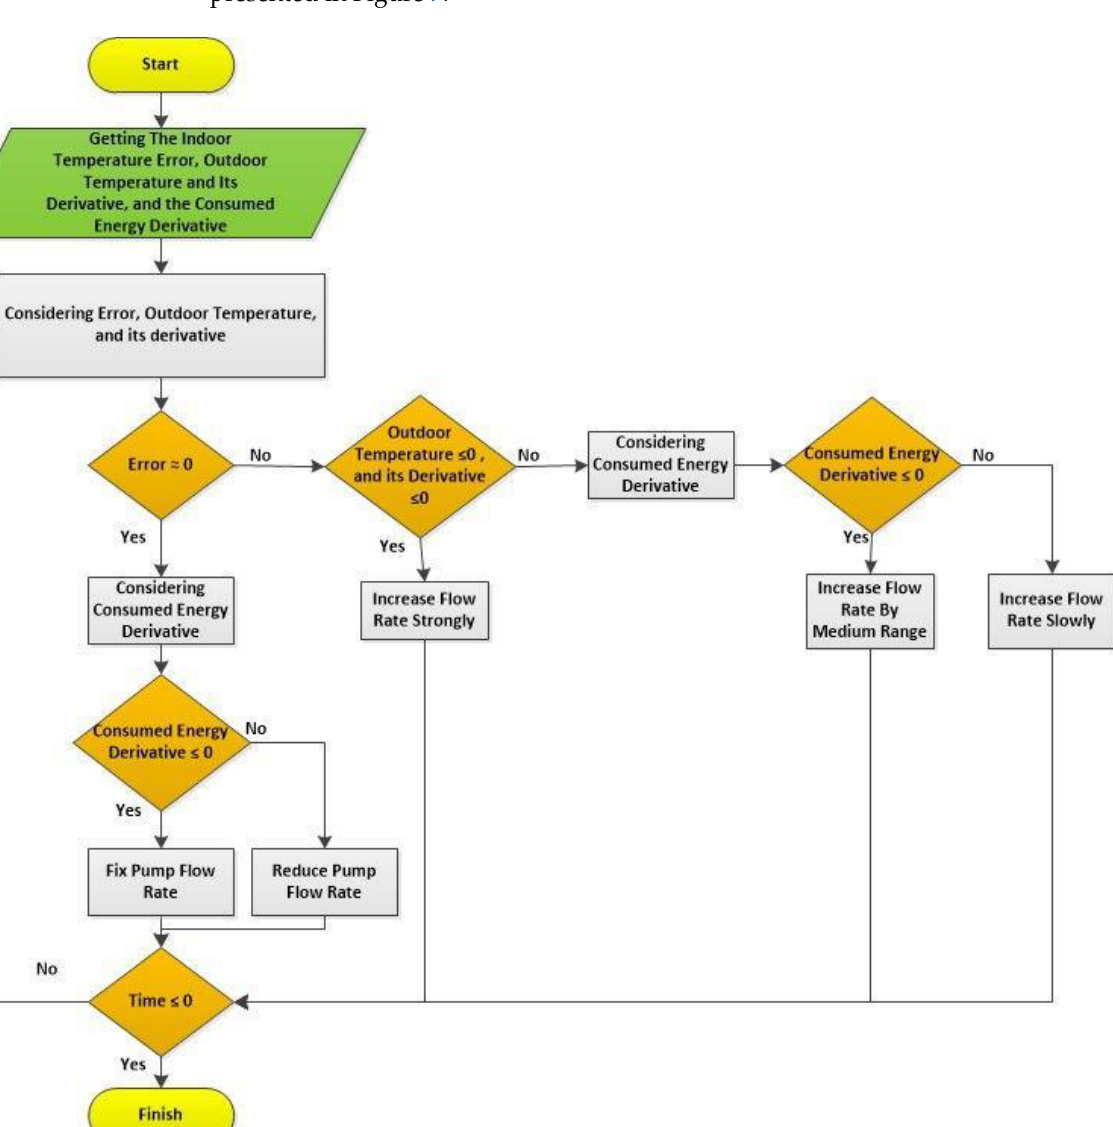
Figure 7. Fuzzy Logic System Flowchart.